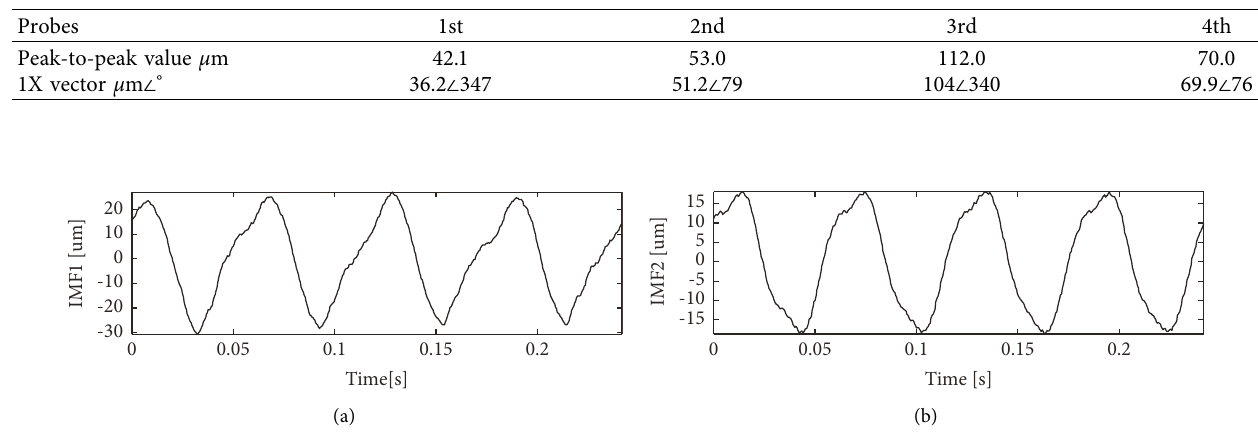
Table 5: Vibration vectors of raw